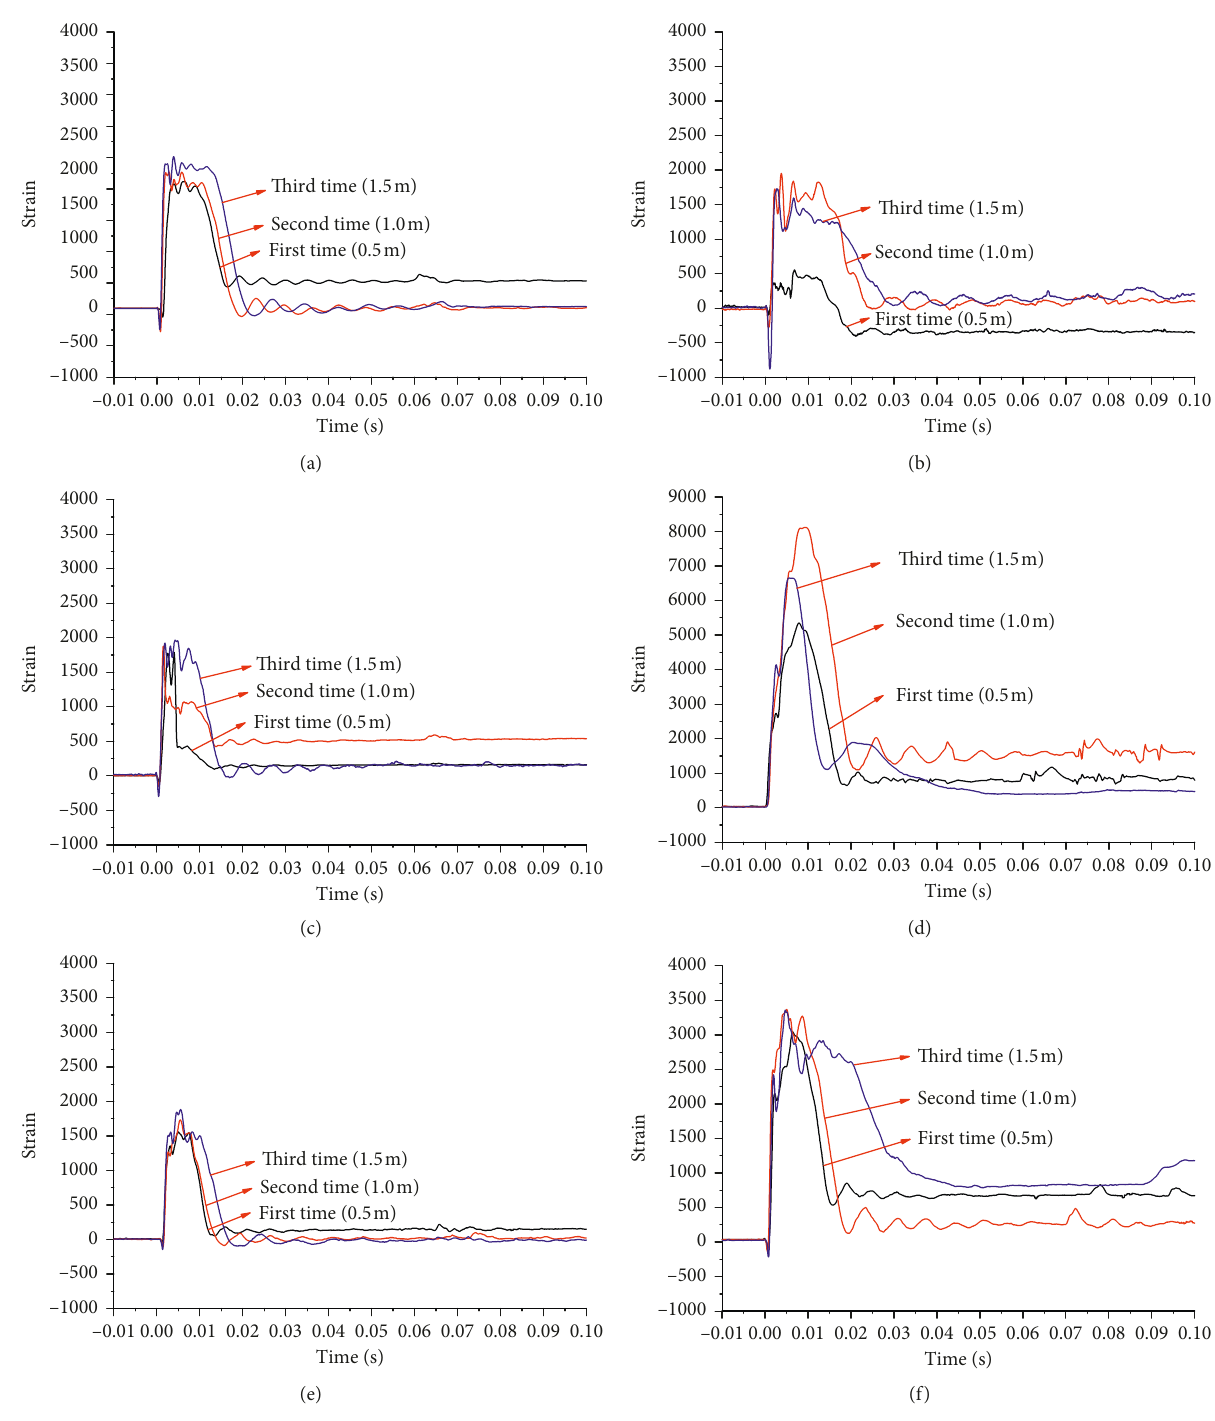
Figure 13: Time history curves of the steel strain. Group A: (a) L18-3# and (b) S12-3#. Group B: (c) L20-3# and (d) S16-3#. Group C: (e) L25-3# and (f)